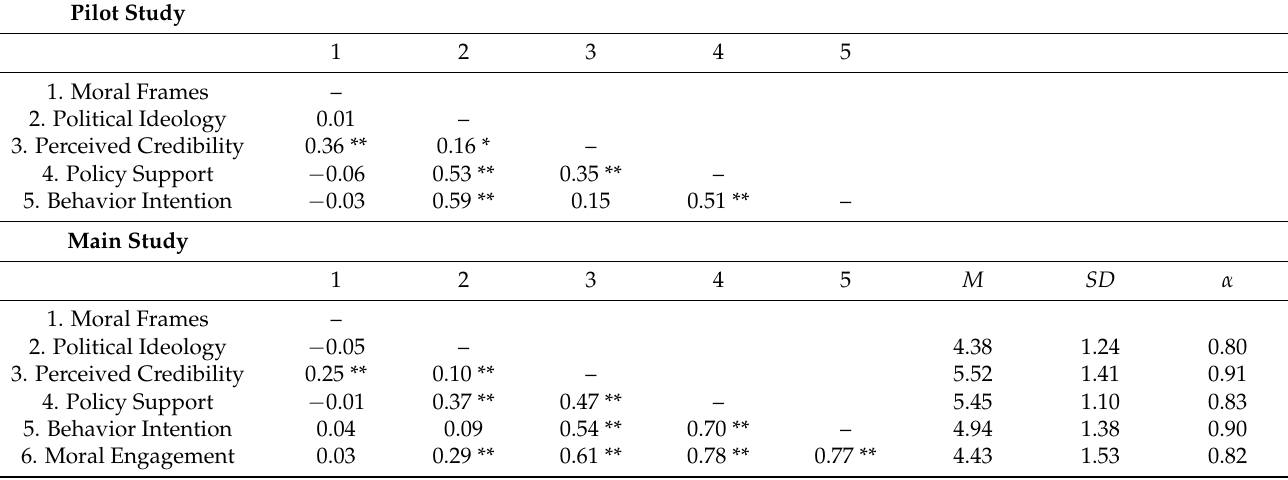
Table 2. Pearson Correlation